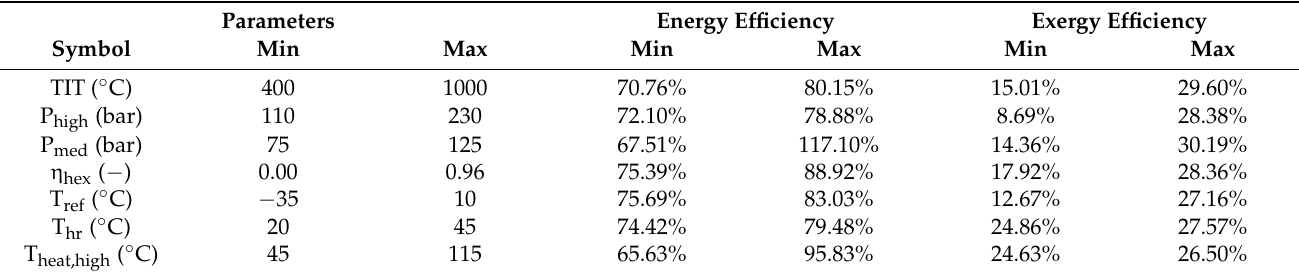
Table 4. The impact of the examined parameters on the energy and exergy efficiencies.